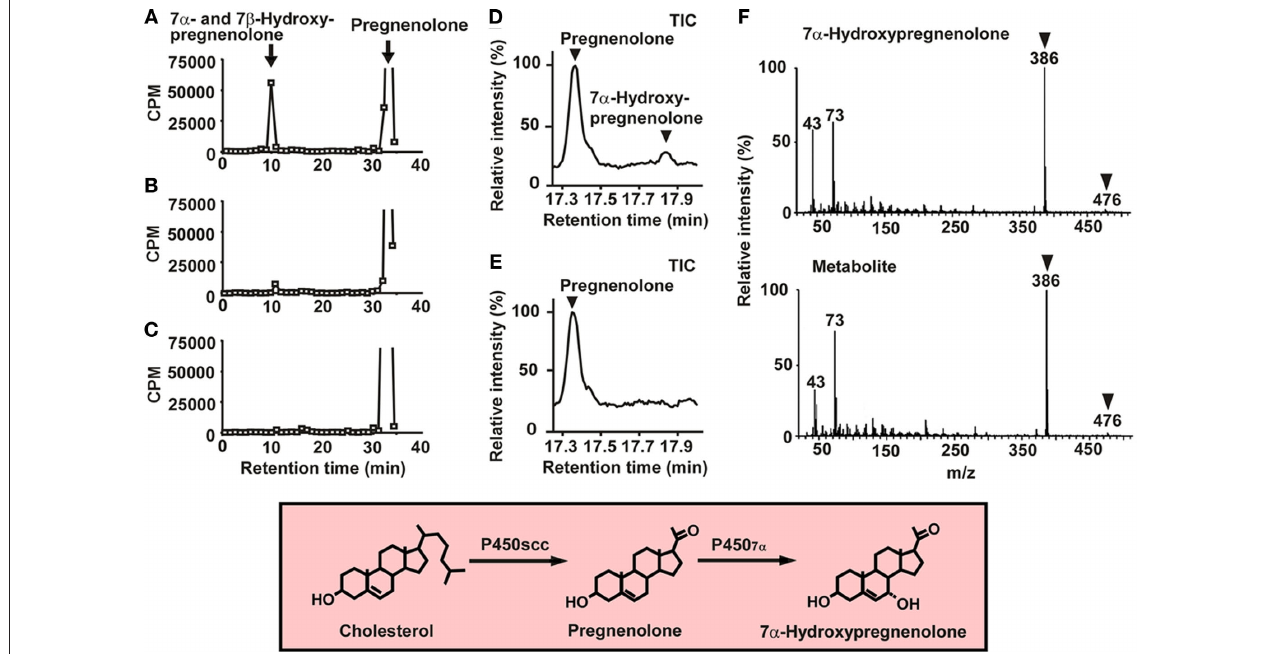
FigurE 2 | 7 α -Hydroxypregnenolone synthesis in COS-7 cells expressing quail P450 . (A) HPLC profile of 7 α - and/or 7 β -hydroxypregnenolone and 7 α pregnenolone extracted from COS-7 cells that were transfected with quail P450 cDNA and incubated with 3 H-pregnenolone. The ordinate indicates the 7 α radioactivity measured in each HPLC fraction, and the arrows indicate